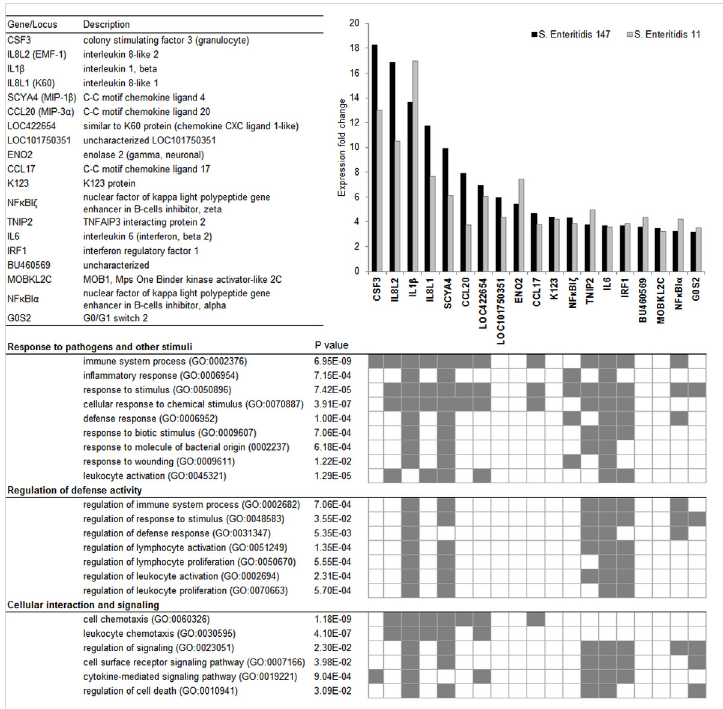
Fig 1. Functional classification of genes induced in CEFs after infection with wild-type S . Enteritidis. Genes are ranked in descending order of their expression fold change. Functional annotation of genes was performed with the STRING database v9.1. and is represented by gene ontology (GO) terms for biological process (BP).